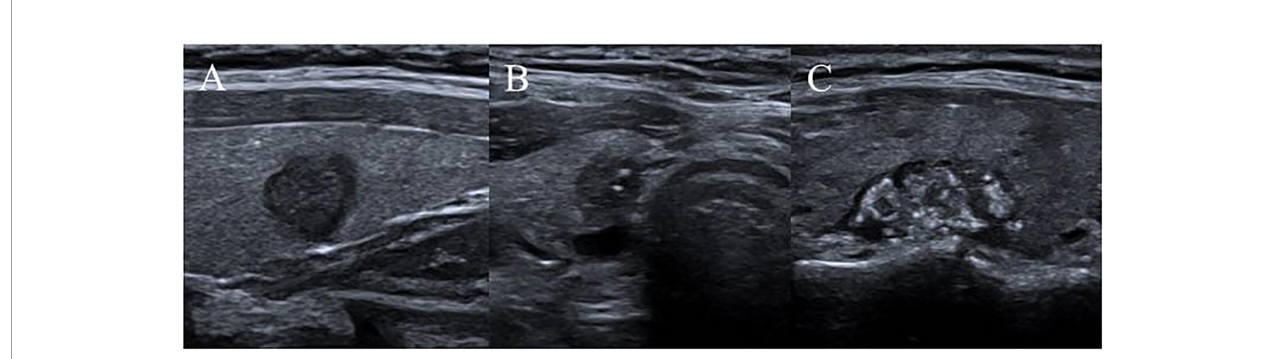
FIGURE 1 | Microcalci fi cations classi fi cation of nodules. (A) no punctate echogenic foci; (B) less than 5 punctate echogenic foci; (C) more than 5 punctate echogenic